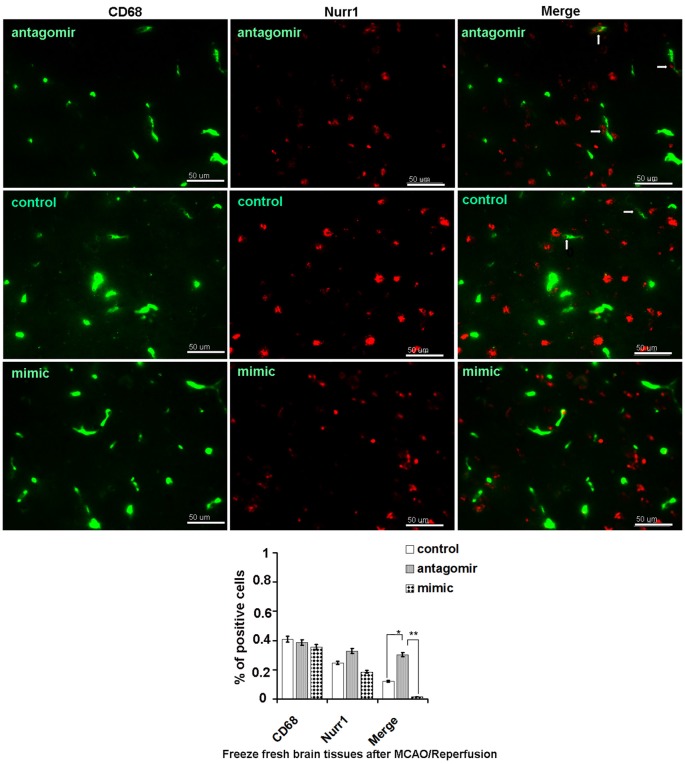
Nurr1 expression in active microglia with administration of miR-145-5p in peri-infarct areas post 12 h of MCAO/R. Double immunofluorescence staining shows more expression of Nurr1 in active microglia with administration of anti-miR-145-5p, and little expression of Nurr1 with administration of miR-145-5p mimic in the peri-infarct areas bordering with intact tissues post 12 h of MCAO/R. Scale bars = 50 μm. Arrows indicate co-localization of CD68 and Nurr1 in active microglia. *p < 0.05, **p < 0.01.